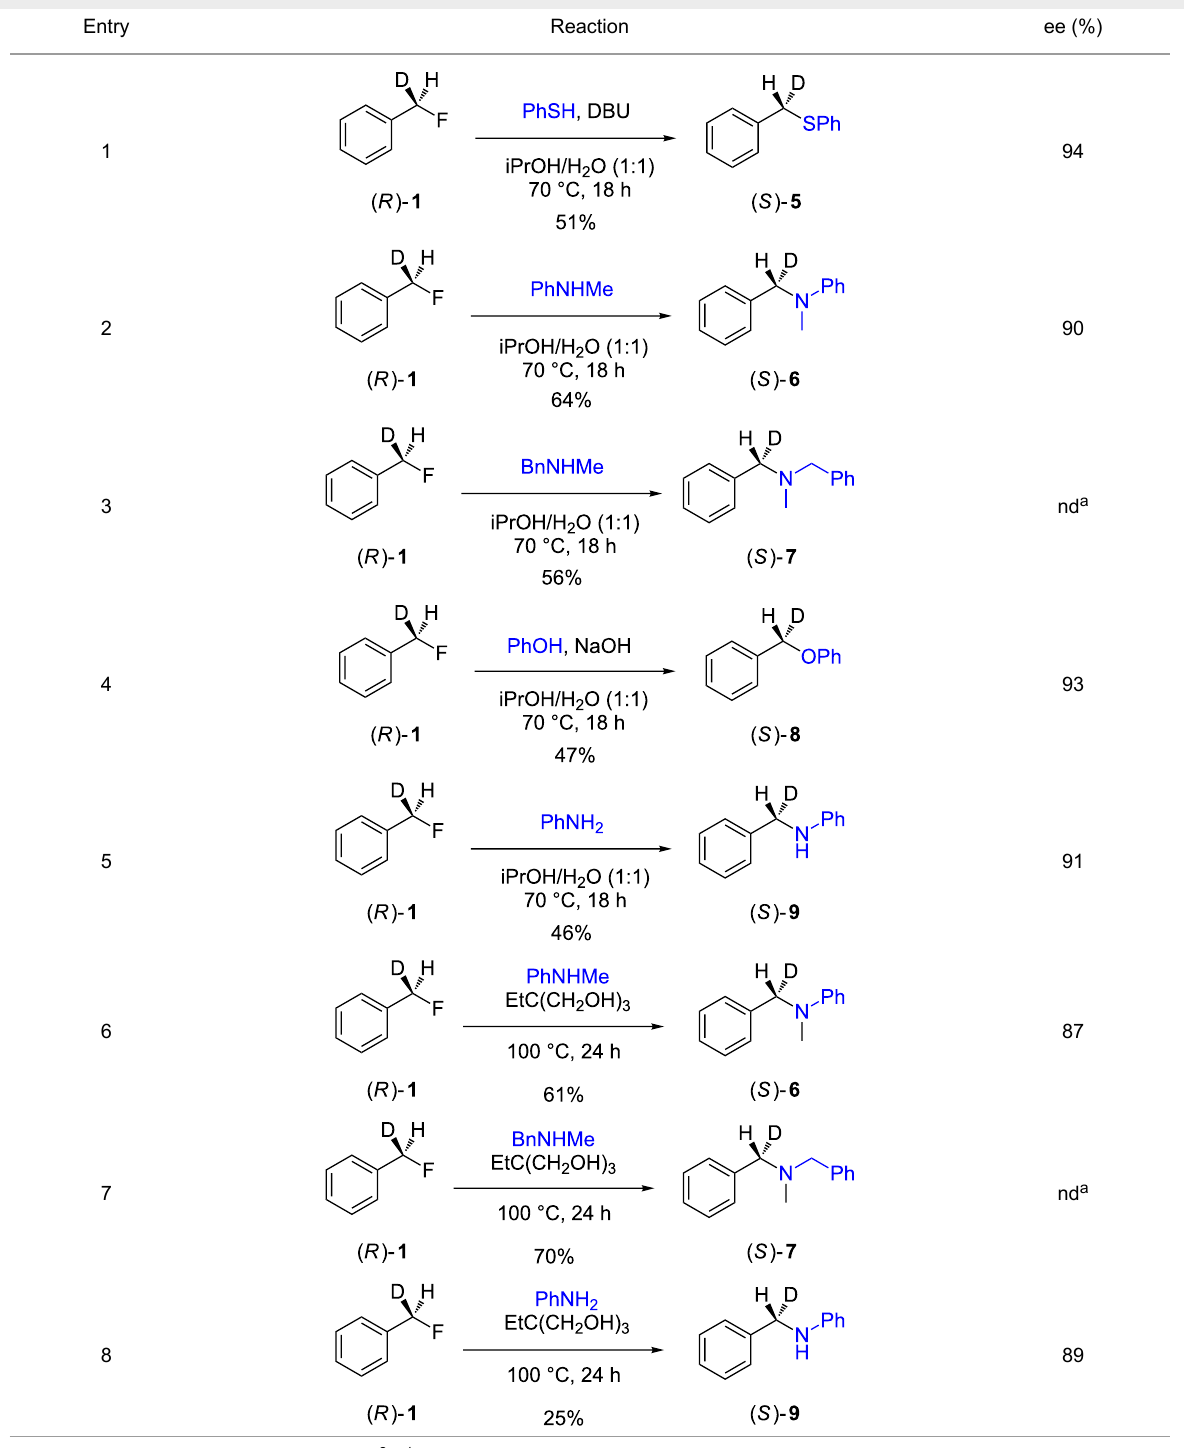
Table 2: Nucleophilic substitution reactions of 7-[ 2 H 1 ]-( R )-benzyl fluoride (( R )- 1